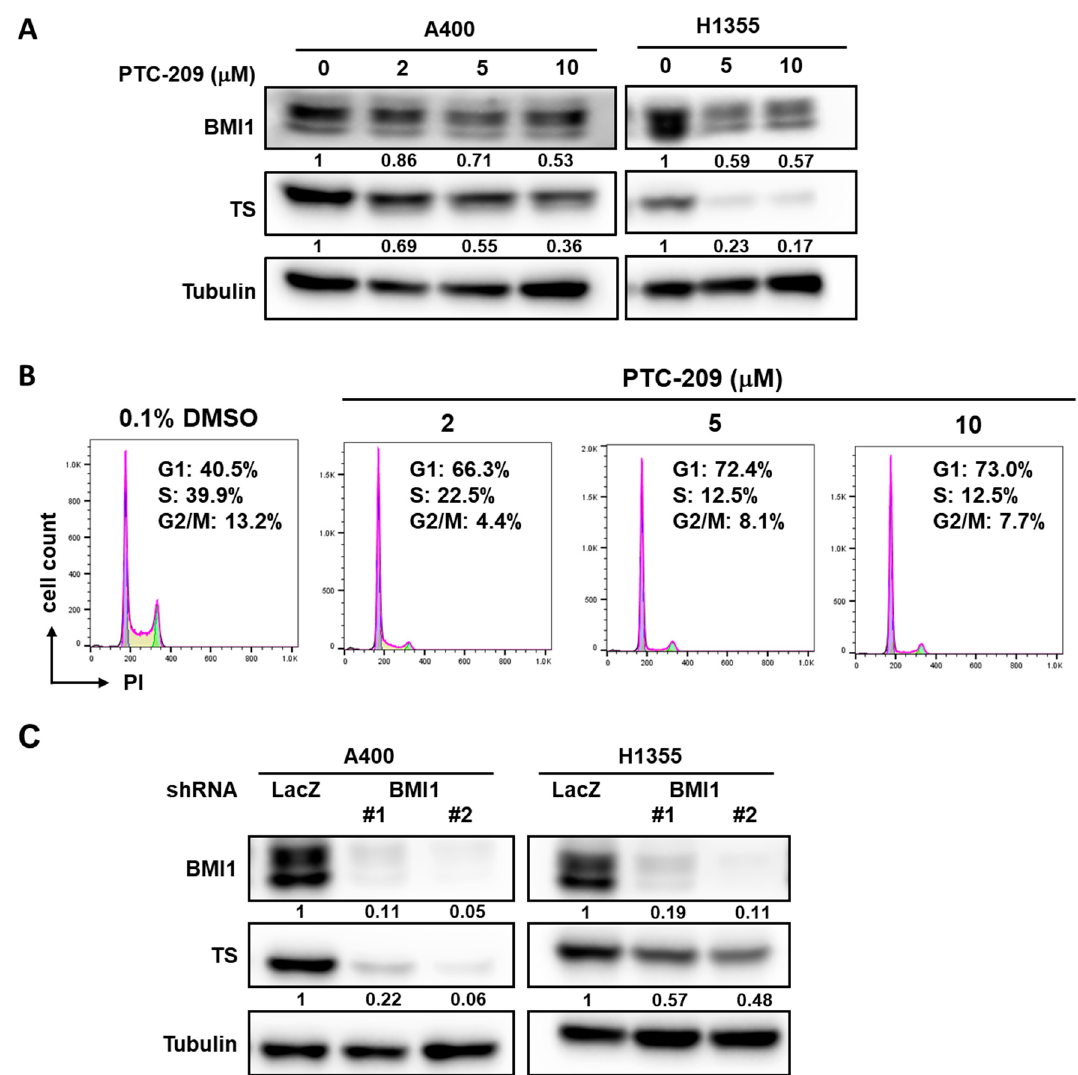
Figure 4. Inhibition of BMI1 in NSCLC cells down-regulates TS expression. ( A ) BMI1 inhibitor, PTC-209, was used to treat A400 or H1355 NSCLC cells at the indicted concentration for 48 h and the total proteins were harvested for determination of BMI1 or TS expression by western blot. ( B ) A400 cells were treated with the indicated concentration of PTC-209 for 24 h and harvested for cell cycle analysis using propidium iodide (PI) staining and the fluorescence was detected by a flow cytometry. As a vehicle control, 0.1% dimethyl sulfoxide (DMSO) was used. The percentage of cells at each cell cycle phase was quantified by FlowJo software. ( C ) A400 or H1355 NSCLC cells were transduced with lentiviruses carrying sh-LacZ or sh-BMI1 (#1 or #2) for 48 h and the protein expression of BMI1 or TS was determined by western blot. All the experiments were done two times and data from one experiment were presented.